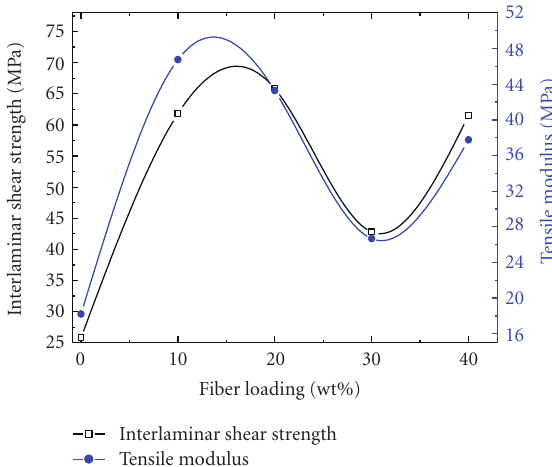
ff ect of fiber loading on interlaminar shear strength and tensile modulus of